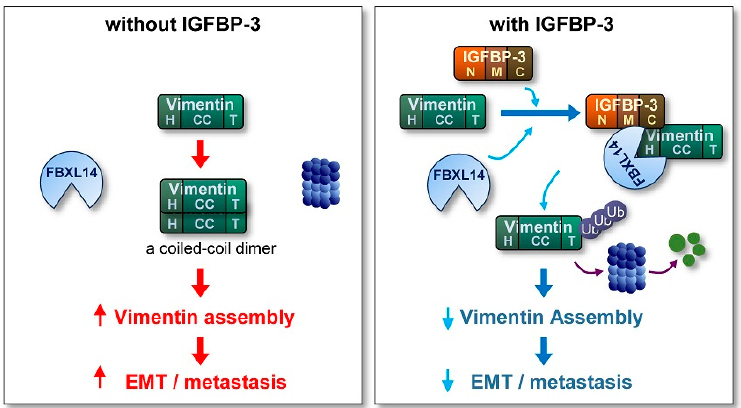
Figure 7. Schematic model of the mechanism underlying the antimetastatic effect of IGFBP-3. In the absence of IGFBP-3, vimentin protein, which is composed of a central α -helical coiled-coil (CC) domain capped on each side by amino (head; H) and carboxyl (tail; T) domains, forms a coiled-coil dimer, the basic subunit of vimentin assembly, eventually stimulating the EMT program and metastasis of cancer cells. In the presence of IGFBP-3, the vimentin head domain makes a direct interaction with the IGFBP-3 C-terminal domain, resulting in the recruitment of the ubiquitin ligase FBXL14 and proteasomal degradation of vimentin. Consequently, assembled vimentin proteins required for the formation of intermediate filament is reduced, eventually suppressing the EMT program and metastasis.